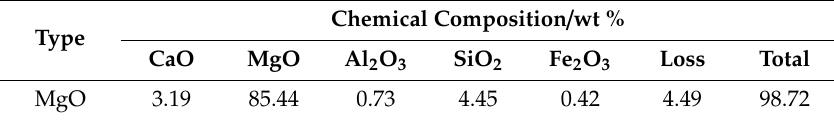
Table 3. Chemical composition of MgO.